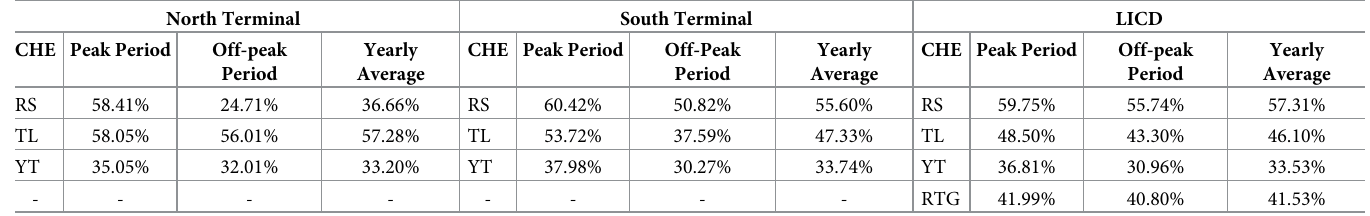
Table 11. Simulation results for scenario S4.